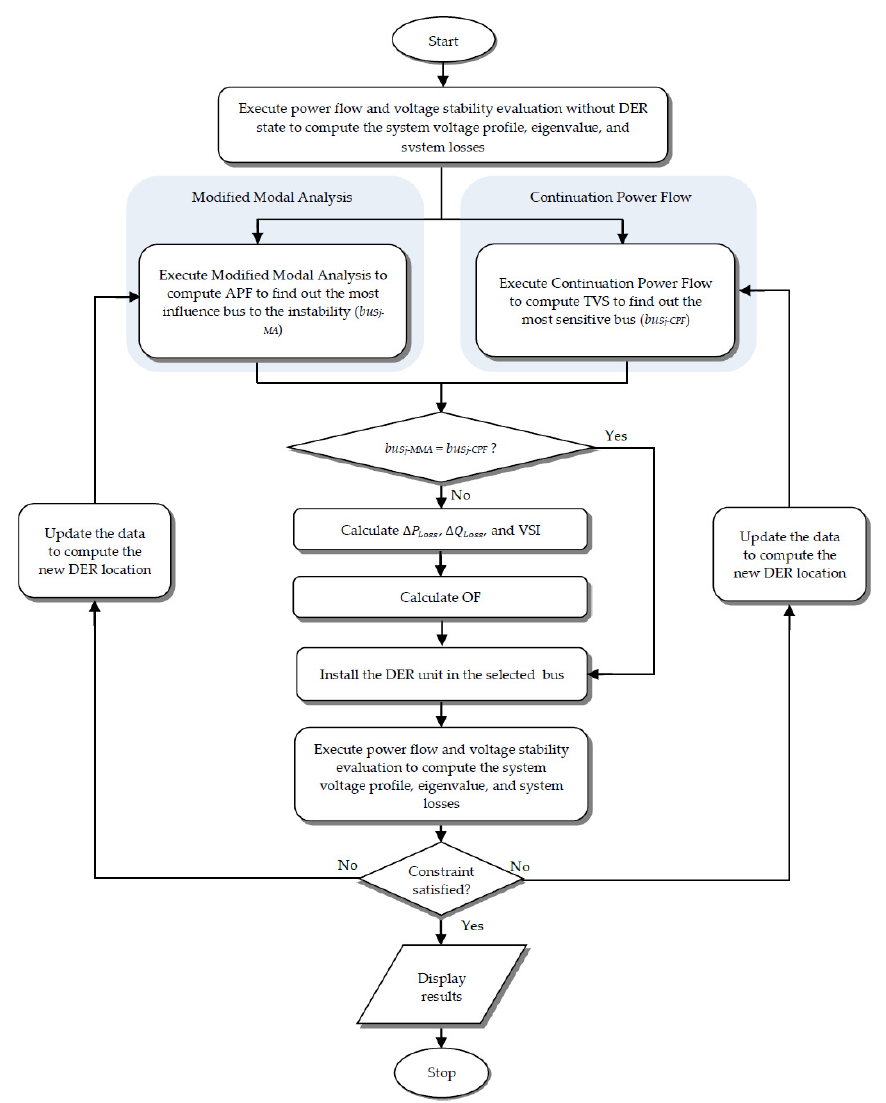
Figure 1. The hybrid MMA–CPF DER allocation approach flowchart.